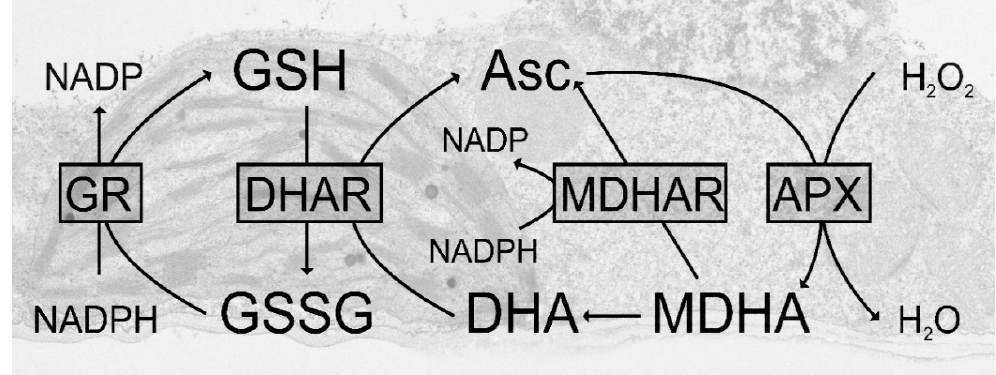
Figure 1. Ascorbate-glutathione cycle. Within the plant cell hydrogen peroxide (H 2 O 2 ) is detoxified by ascorbate peroxidase (APX). Through this reaction, the reduced form of ascorbate (Asc) is oxidized to monodehydroascorbate (MDHA). MDHA is then further reduced by monodehydroascorbate reductase (MDHAR) to Asc, or reacts to dehydroascorbate (DHA). DHA is reduced by dehydroascorbate reductase (DHAR) to Asc. Through this reaction, the reduced form of glutathione (GSH) is oxidized to glutathionedisulfide (GSSG). GSSG is then reduced by glutathione reductase (GR) to GSH. The electron acceptor NADP is regenerated during the reduction of MDHA and GSSG by the respective enzymes.